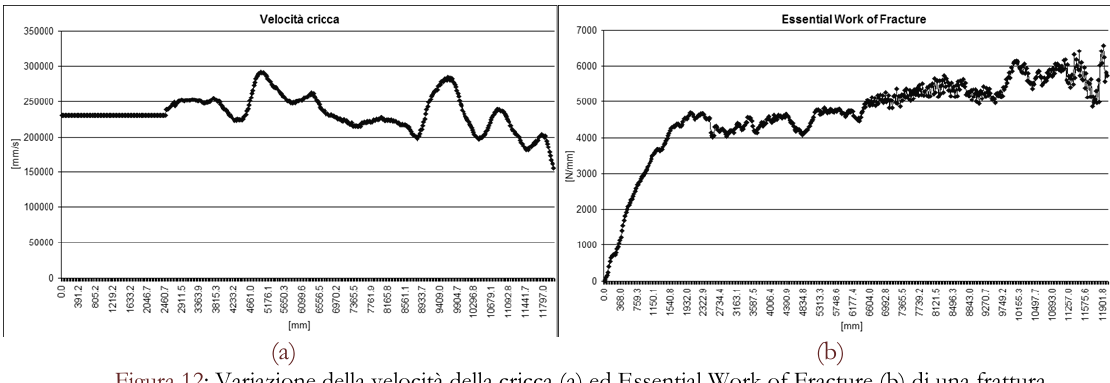
Figura 12: Variazione della velocità della cricca (a) ed Essential Work of Fracture (b) di una frattura in controllo di CTOA (CTOA c = 16°) su un modello con mesh di TIPO